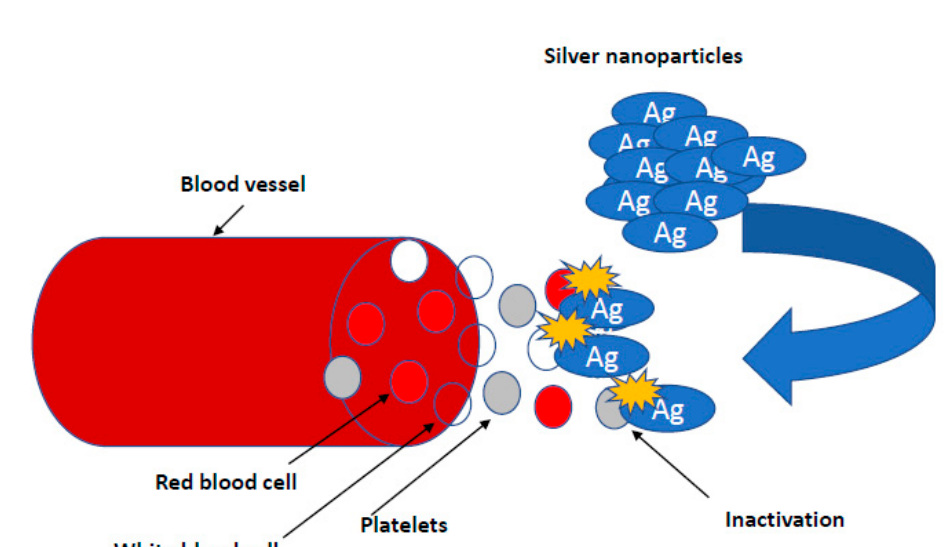
Figure 6. Nanoparticles in research on angiogenesis. Silver nanoparticles can also be an effective carrier for amino acids or ATP. When administered by the in ovo method, they stimulated the development and maturation of muscle fibers by activating PCNA and increasing the surface area of breast muscle fibers. The observed mechanism was associated with an increase in the metabolic rate determined by measuring oxygen.